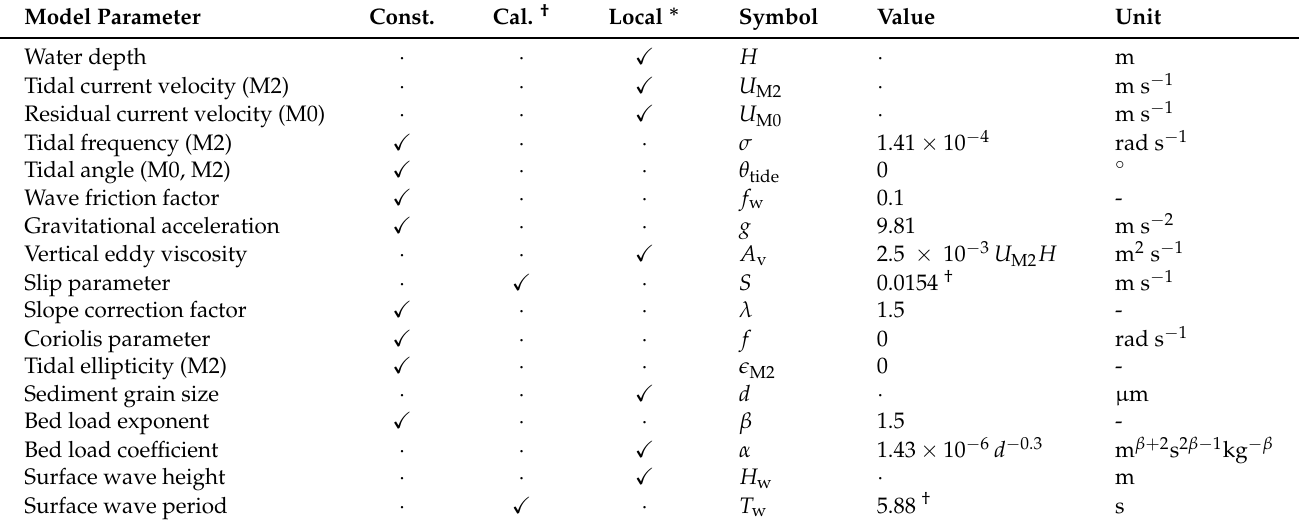
Surface wave period (cid:88) ∗ Local data from Damen et al. [12,33]; see Tables 2 and 3. Vertical eddy viscosity is derived from these data via the water depth and tidal current velocity (M2). † Values obtained from the calibration procedure. The (cid:88) indicates weather the parameter is a constant, a location dependent parameter, or a (location independent) parameter used in the calibration